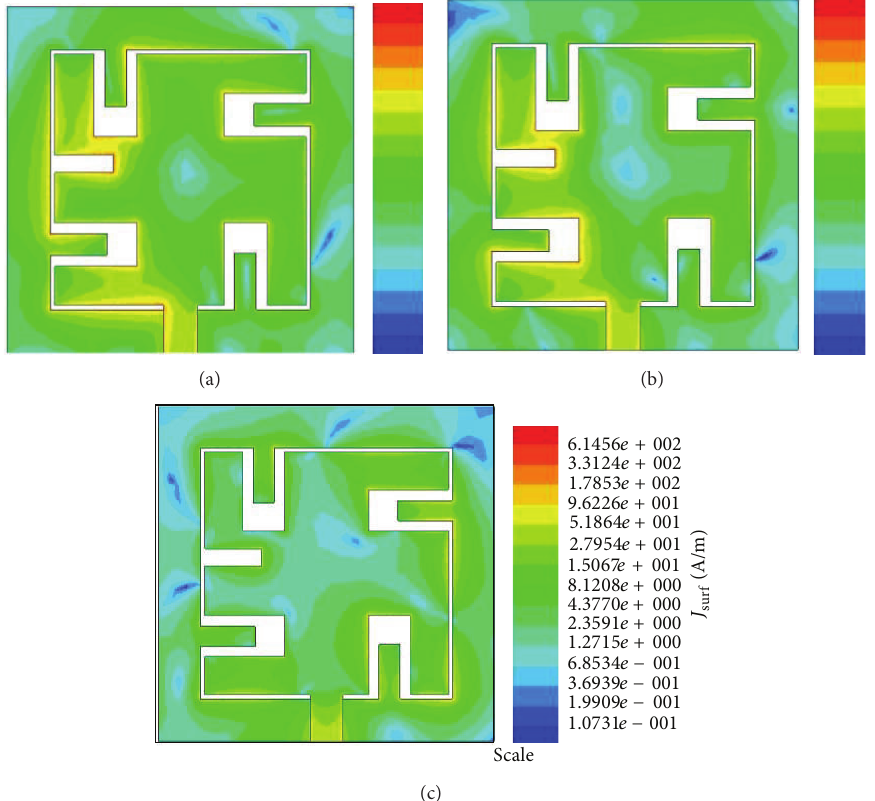
Figure 11: Simulated surface current distribution of the proposed antenna at (a) 2.50 GHz, (b) 3.48 GHz, and (c) 5.30 GHz.